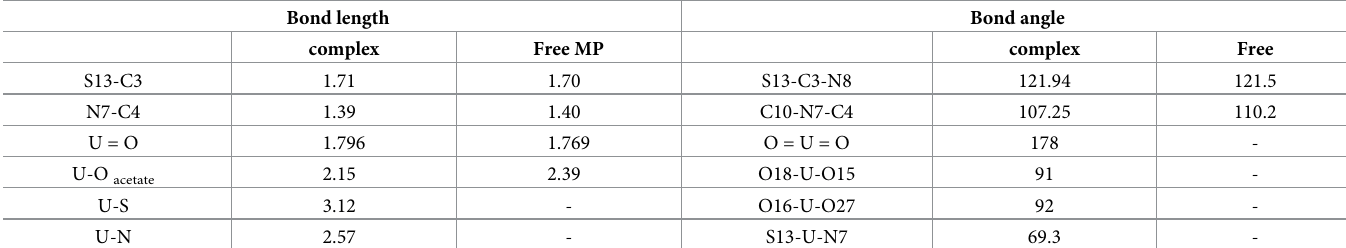
Table 4. Geometric ( Å , deg) comparison of free ligand/ uranyl acetate and calculated structures for [(UO 2 )(OAc) 2 (MP)].